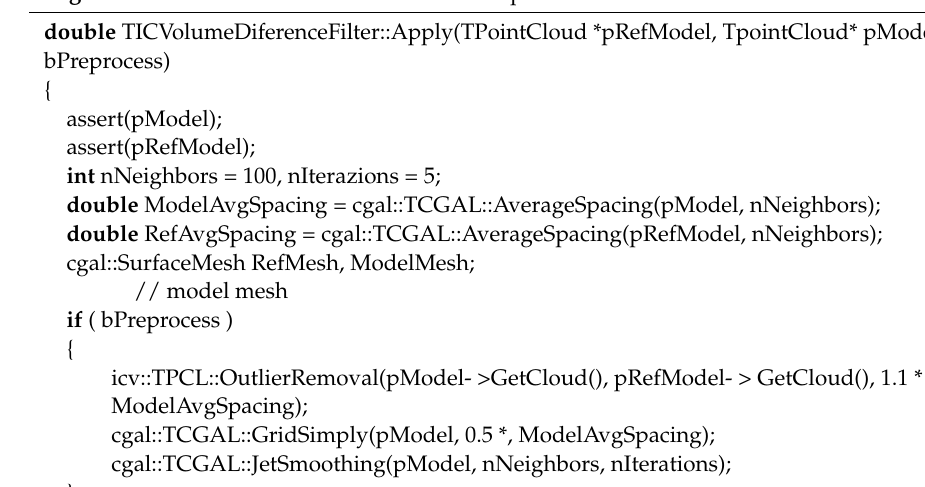
Algorithm A2 Volume difference between two point